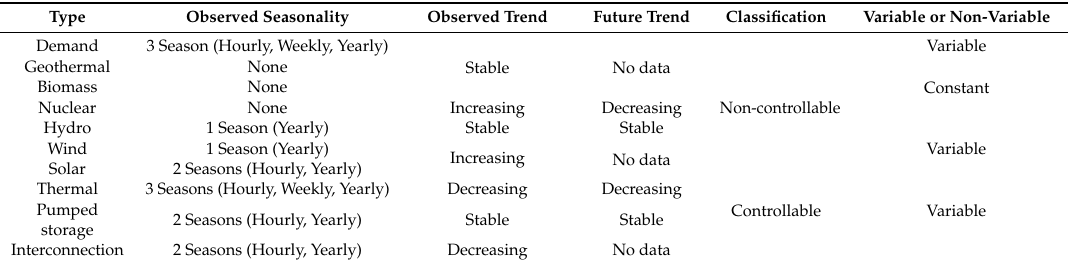
Table 3. Classification of supply and demand types.